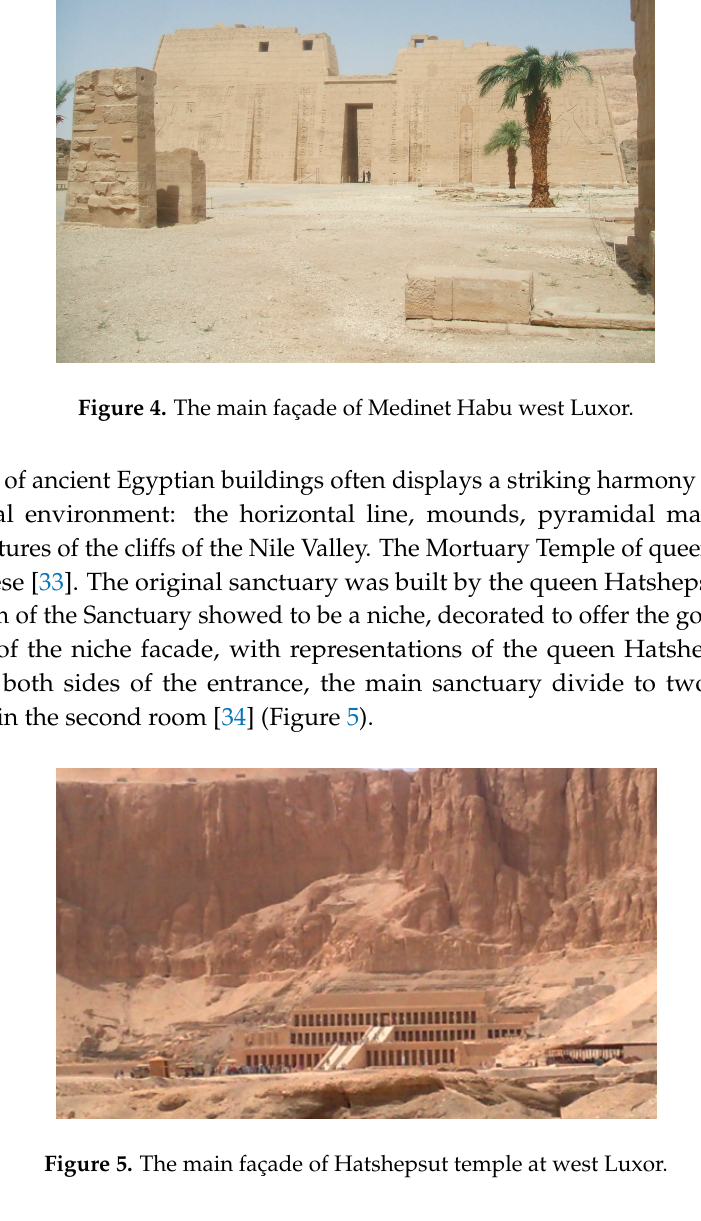
Figure 3. The main façade of Luxor temple at east Luxor.